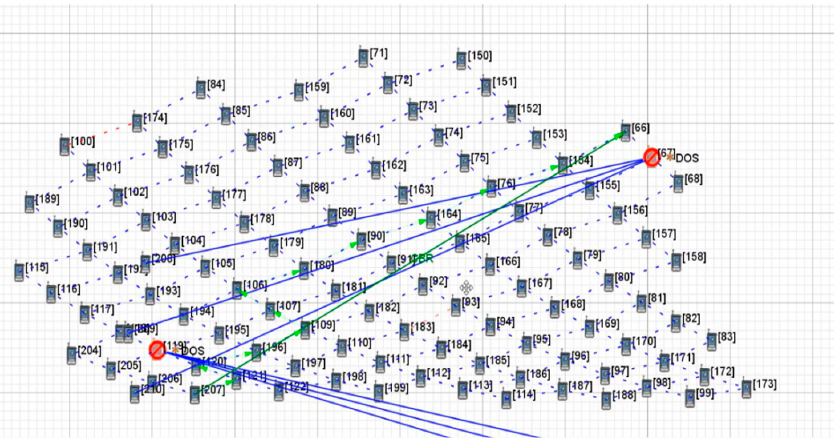
Sensors 2022 , 22 , x FOR PEER REVIEW Figure 4. Two–satellite–key–node attack scenario under OSPFv2 protocol. Figure 4. Two-satellite-key-node attack scenario under OSPFv2 protocol.